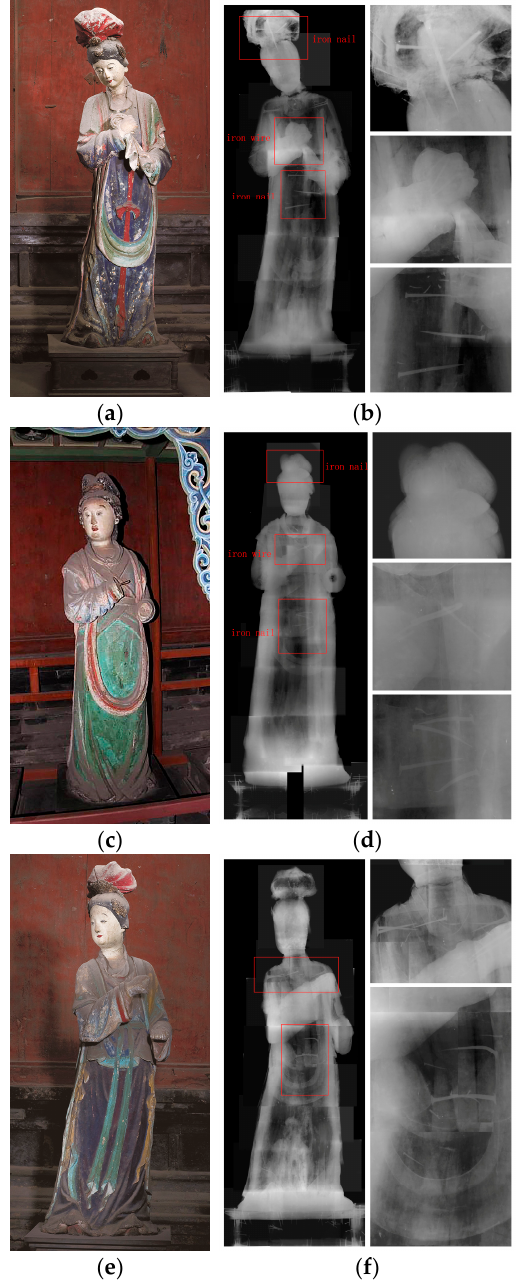
Figure 6. Visible and X-ray images of the polychrome statues. ( a , c , e ) CS27, CS29, CS30, visible light photographs; ( b , d , f ) CS27, CS29, CS30, X-radiographic images. X-radiography was unable to generate the desired image effect because of the stat- ues’ material qualities, namely, their thicker clay layers. The results of X-radiography show that the wooden bones of the statues are vertically connected by iron nails. Addi- tionally, the wooden skeleton of the CS30 statue can be clearly seen to be built in the